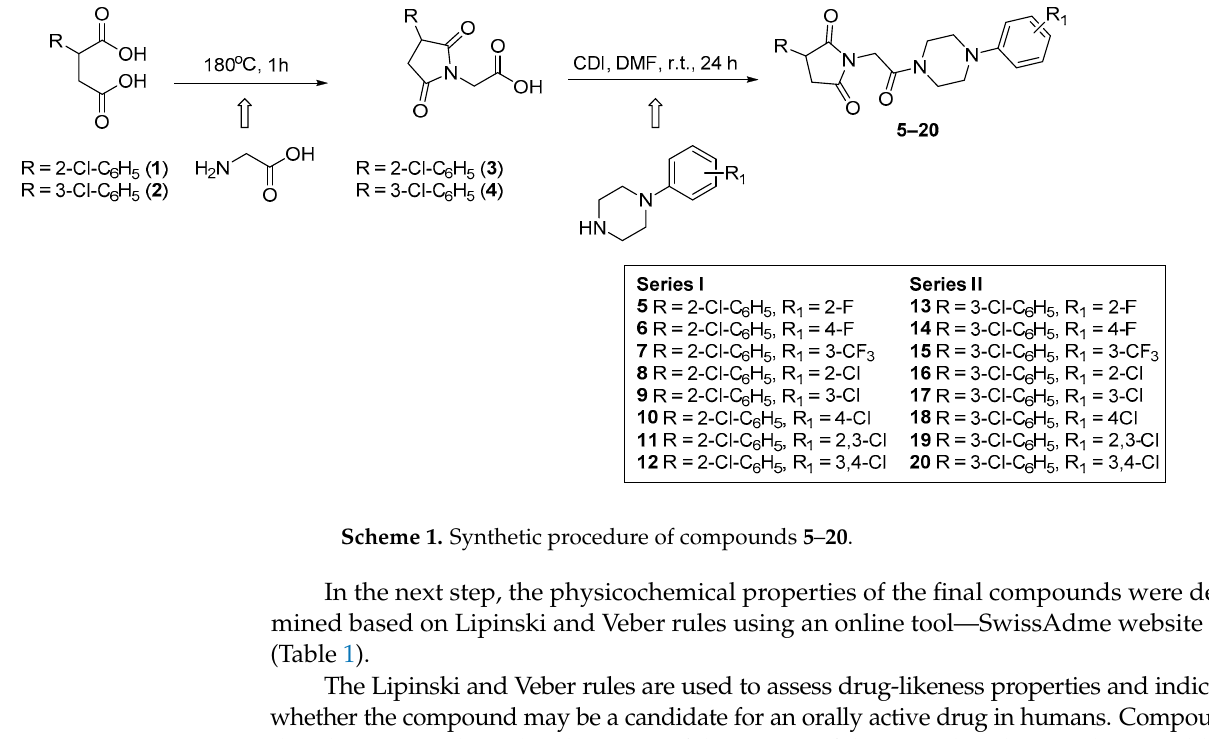
Table 1. Drug-likeness parameters according to Lipinski and Veber rules.